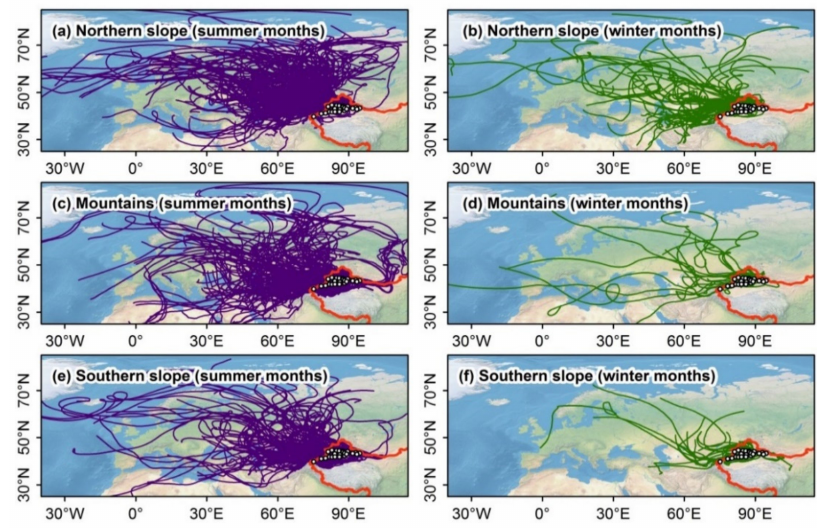
Figure 2. Spatial distribution of the 10 day backward trajectories for the sampling sites around the Tianshan Mountains during precipitation days.